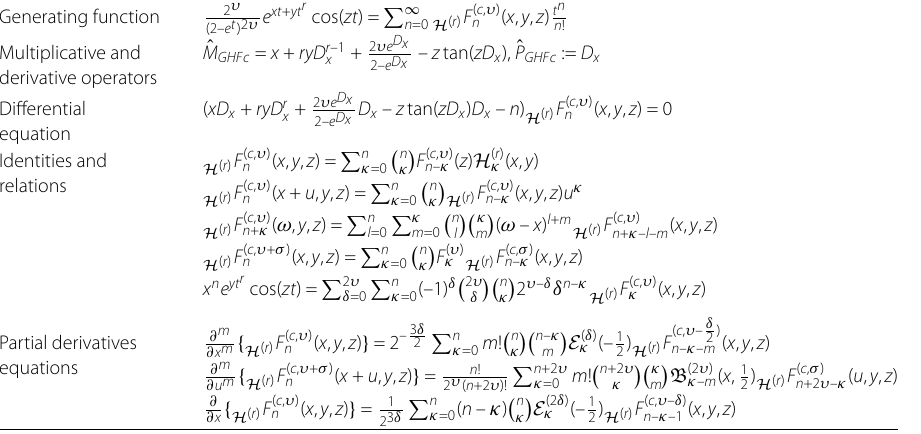
Table 2 Results for H ( r ) F ( c , υ ) n ( x , y , z ) Generating function